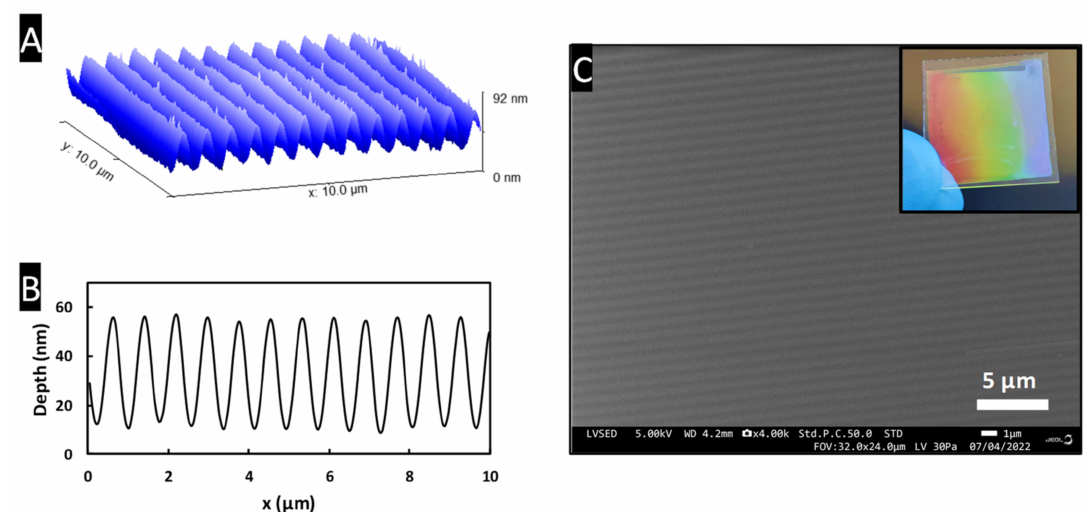
Figure 6. Example of structuring on planar glass substrates: ZrO 2 xerogel sub-micronic diffraction grating. ( A , B ) AFM 3D image and profile of the nano-structured ZrO 2 thin film. ( C ) SEM top view image of the ZrO 2 diffraction grating with an inset picture showing the iridescence phenomenon of the structured ZrO 2 layer.